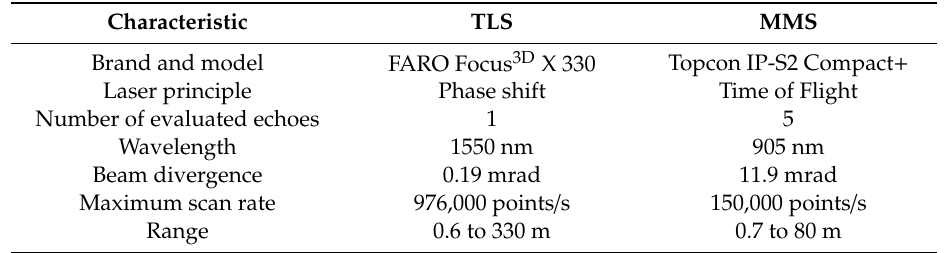
Figure 5. Test area, location of the VSAOs, TLS stations, and MMS trajectory (EPSG:3857).